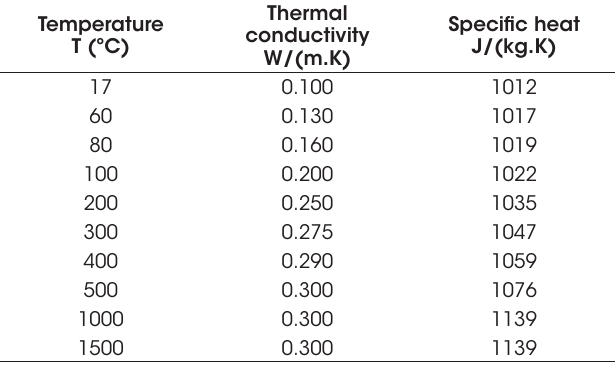
Thermal properties of air used in the